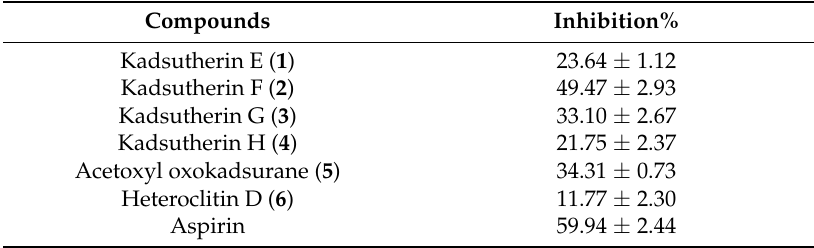
Table 3. Inhibitory effects of compounds on the aggregation of rat platelets induced by adenosine diphosphate (ADP) (100 µ M, n =